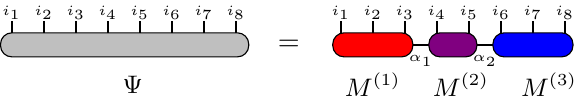
FIG. 3. Decomposition of an eight-qubit state as a three-tensor